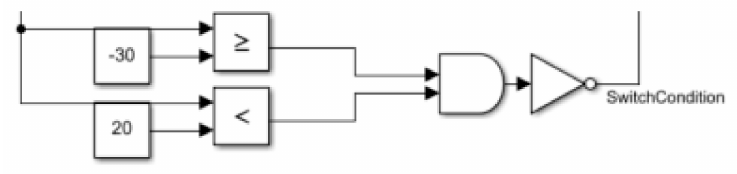
Figure 16. Condition for combustion and compression-expansion